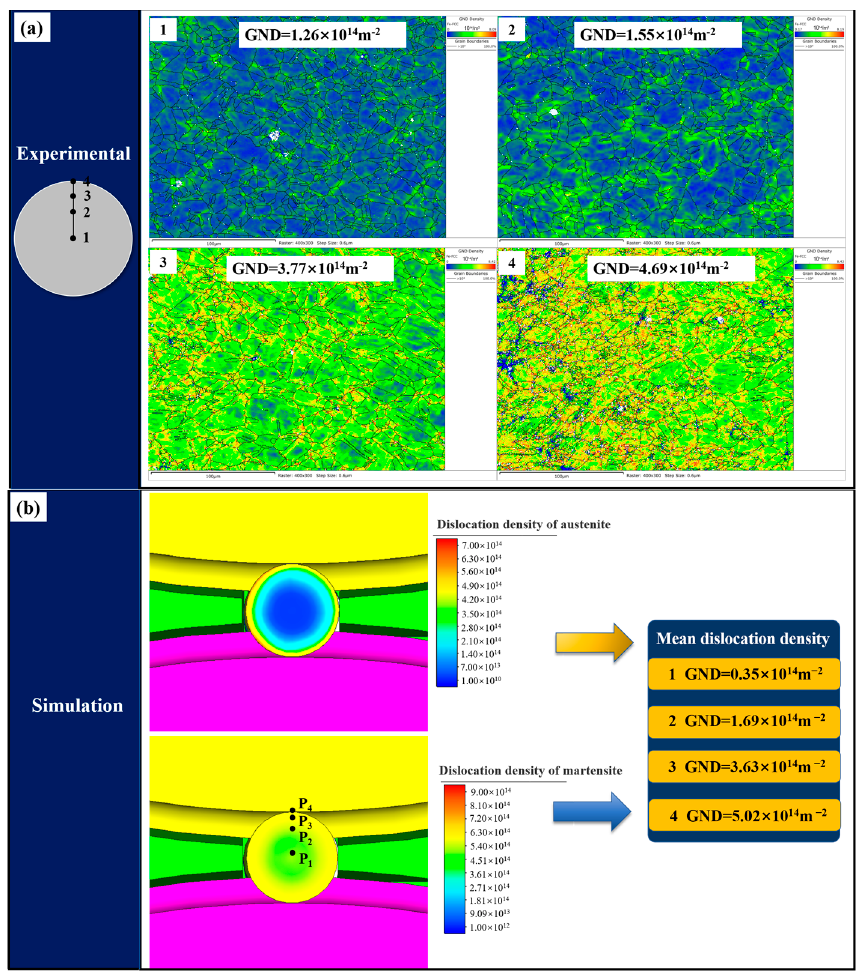
Figure 6. Comparison of dislocation density at different positions in transverse section of steel balls: ( a ) experimental results and ( b ) simulation results.